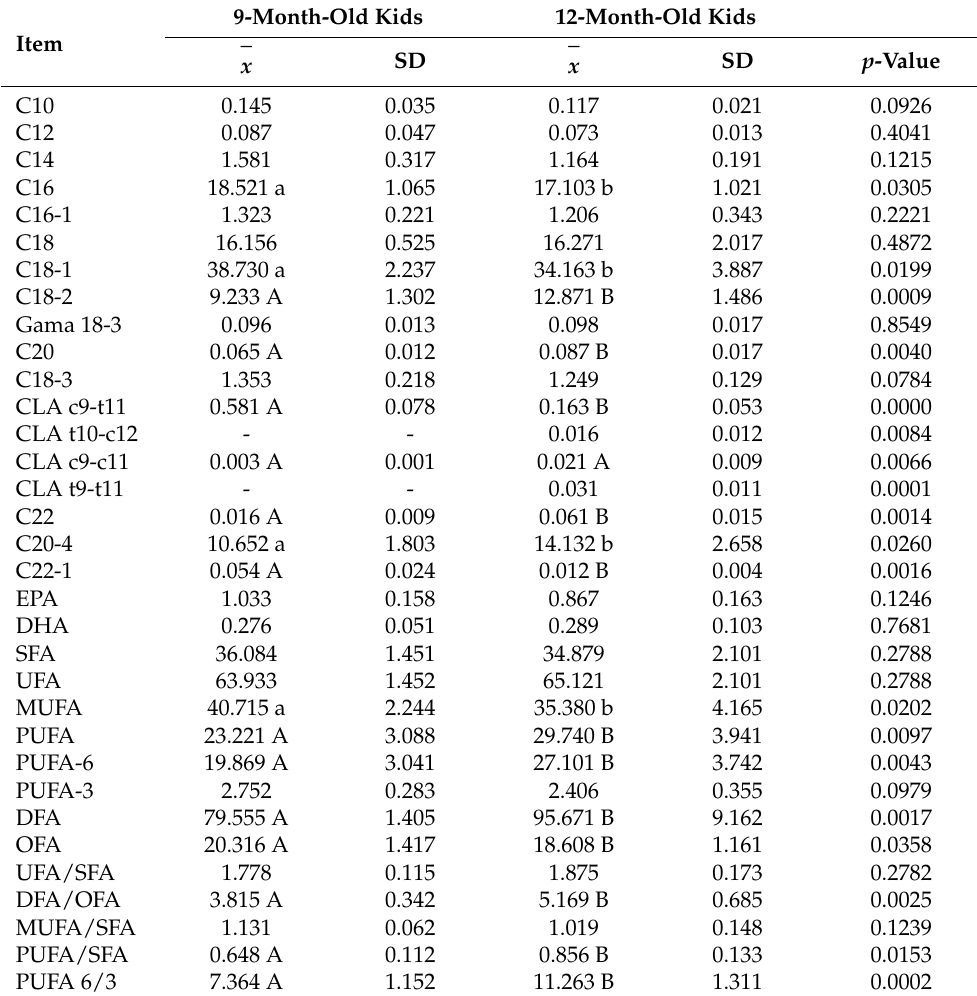
Table 4. Fatty acid composition in intramuscular fat from kid’s meat (g/100 g of lipid).